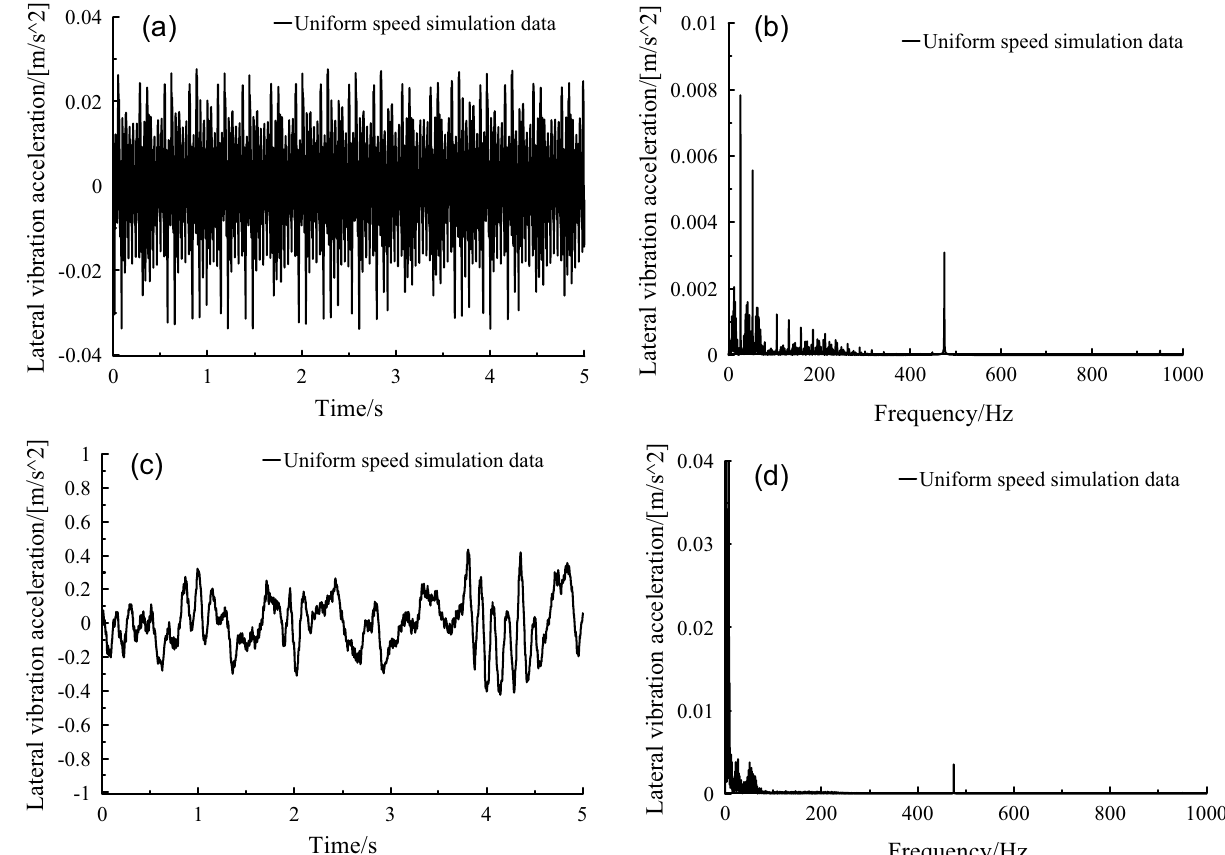
Figure 5. Frame lateral vibration acceleration, (a-b) orbit free spectrum, (c-d) orbital